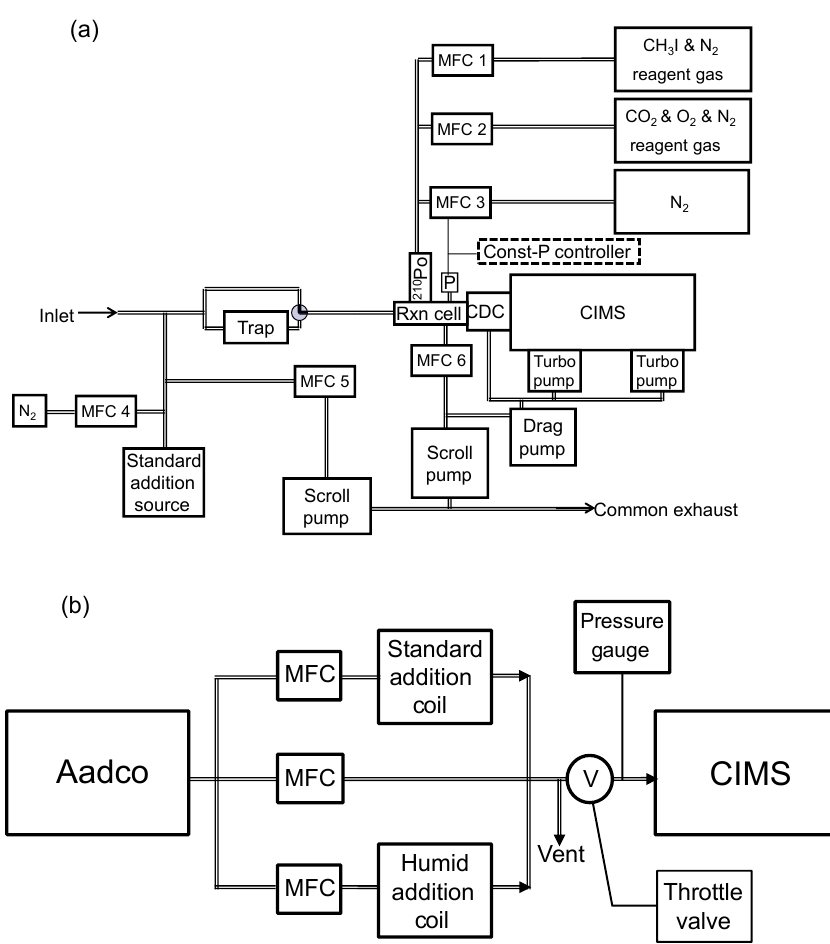
Figure 1. (a) The peroxide chemical ionization mass spectrometer (PCIMS) instrument is diagramed in panel (a) . The inlet samples either ambient air or laboratory-generated pure air (Aadco Instruments Inc., Cleves, OH). RXN refers to the ion reaction cell, CDC refers to the octopole collision dissociation chamber, and MFC indicates a mass flow controller and corresponds to the numbers in Table 1. CIMS represents the quadrupole mass spectrometer. (b) Laboratory calibration instrumental set up. Aadco is a pure air generator. CIMS in panel (b) represents the full PCIMS instrument illustrated in panel (a)